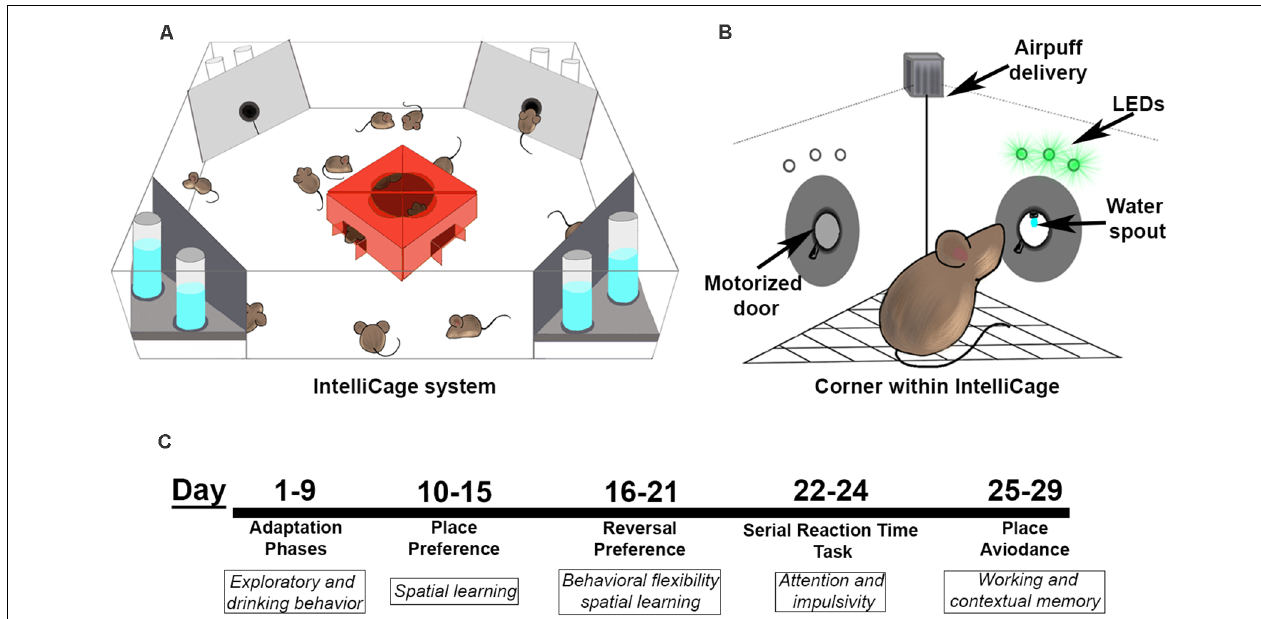
FIGURE 1 | The IntelliCage and testing paradigm. (A) The IntelliCage accommodates up to 16 mice at a time and contains four corners that are programmed to allow water access based on nose port responses. (B) Each corner in the IntelliCage is equipped with two nose ports with doors, LEDs above each nose port, an air delivery nozzle, and access to water with a lickometer to detect drinking behavior. (C) Behavioral battery timeline for the IntelliCage study. Mice started testing at a range of 7–9 months of age.